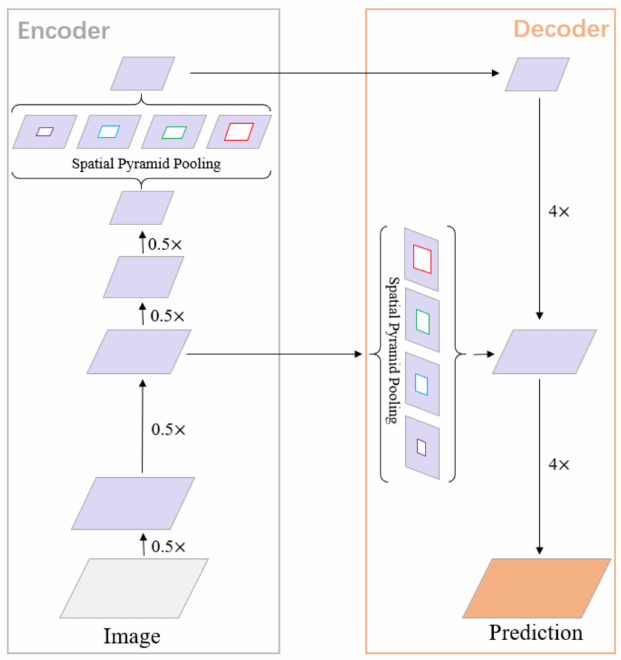
Figure 5. Vertical structure of semantic segmentation of microvascular decompression